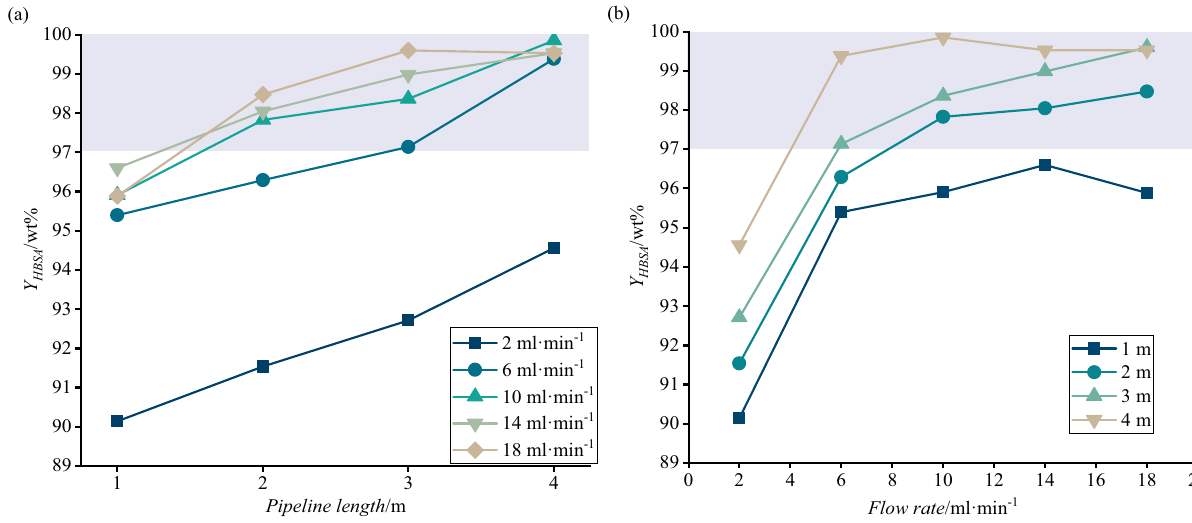
Figure 10: E ff ect of pipeline length on HBSA yield under di ff erent total velocity conditions. ( a ) E ff ect of total velocity on HBSA yield under various pipeline lengths and ( b ) a reaction temperature of 50°C, SO 3 mass fraction of 10 wt% and SO 3 :HDB molar ratio of 1.10:1. The pale navy blue parts indicate the range of HBSA content in the superior